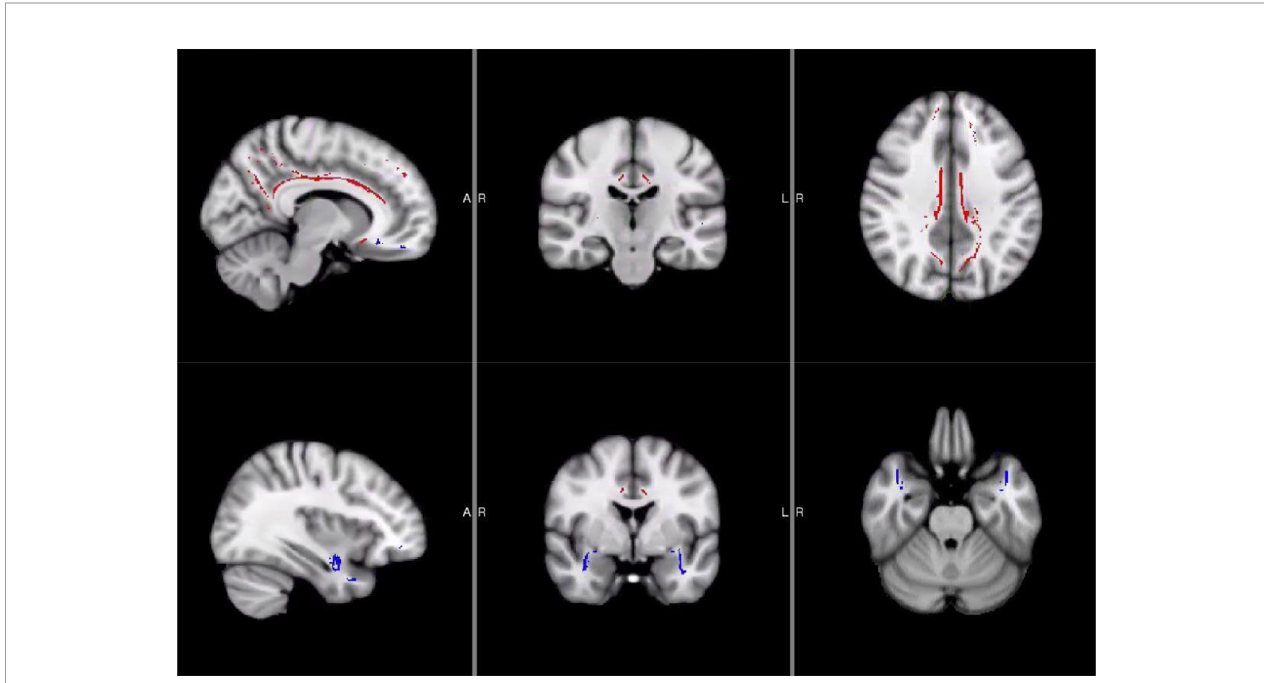
FIGURE 1 | Locations of Uncinate Fasciculus and Cingulum Masks. Areas in red were used for the cingulum masks while blue areas were used for the uncinate fasciculus